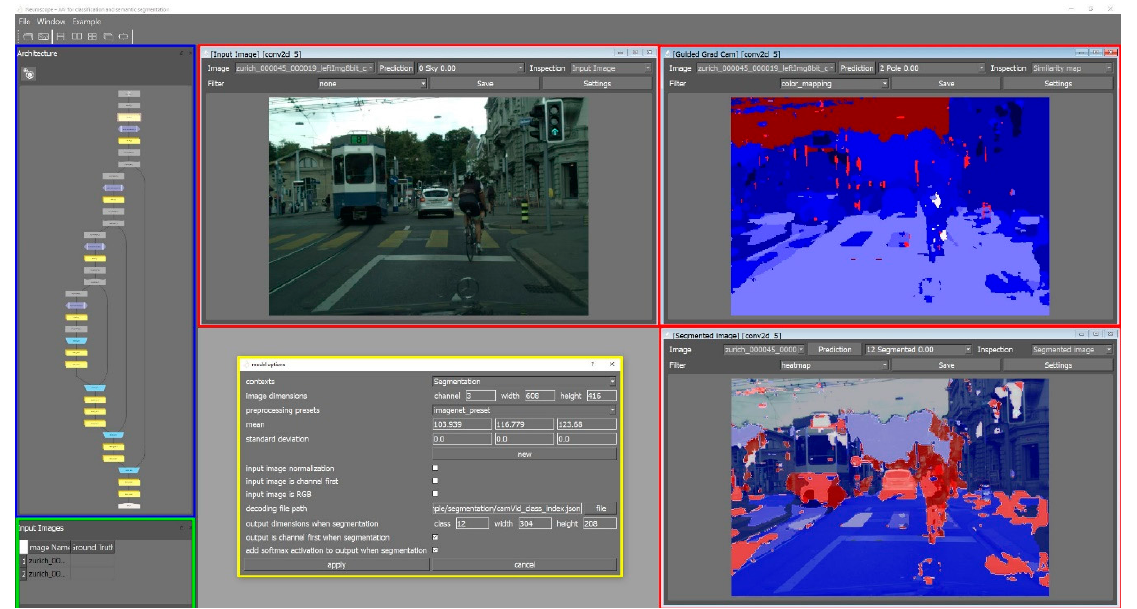
Figure 6. Screenshot of the Neuroscope graphical user interface (GUI): blue: architecture view, green: image list, yellow: model options, red: inspection windows.